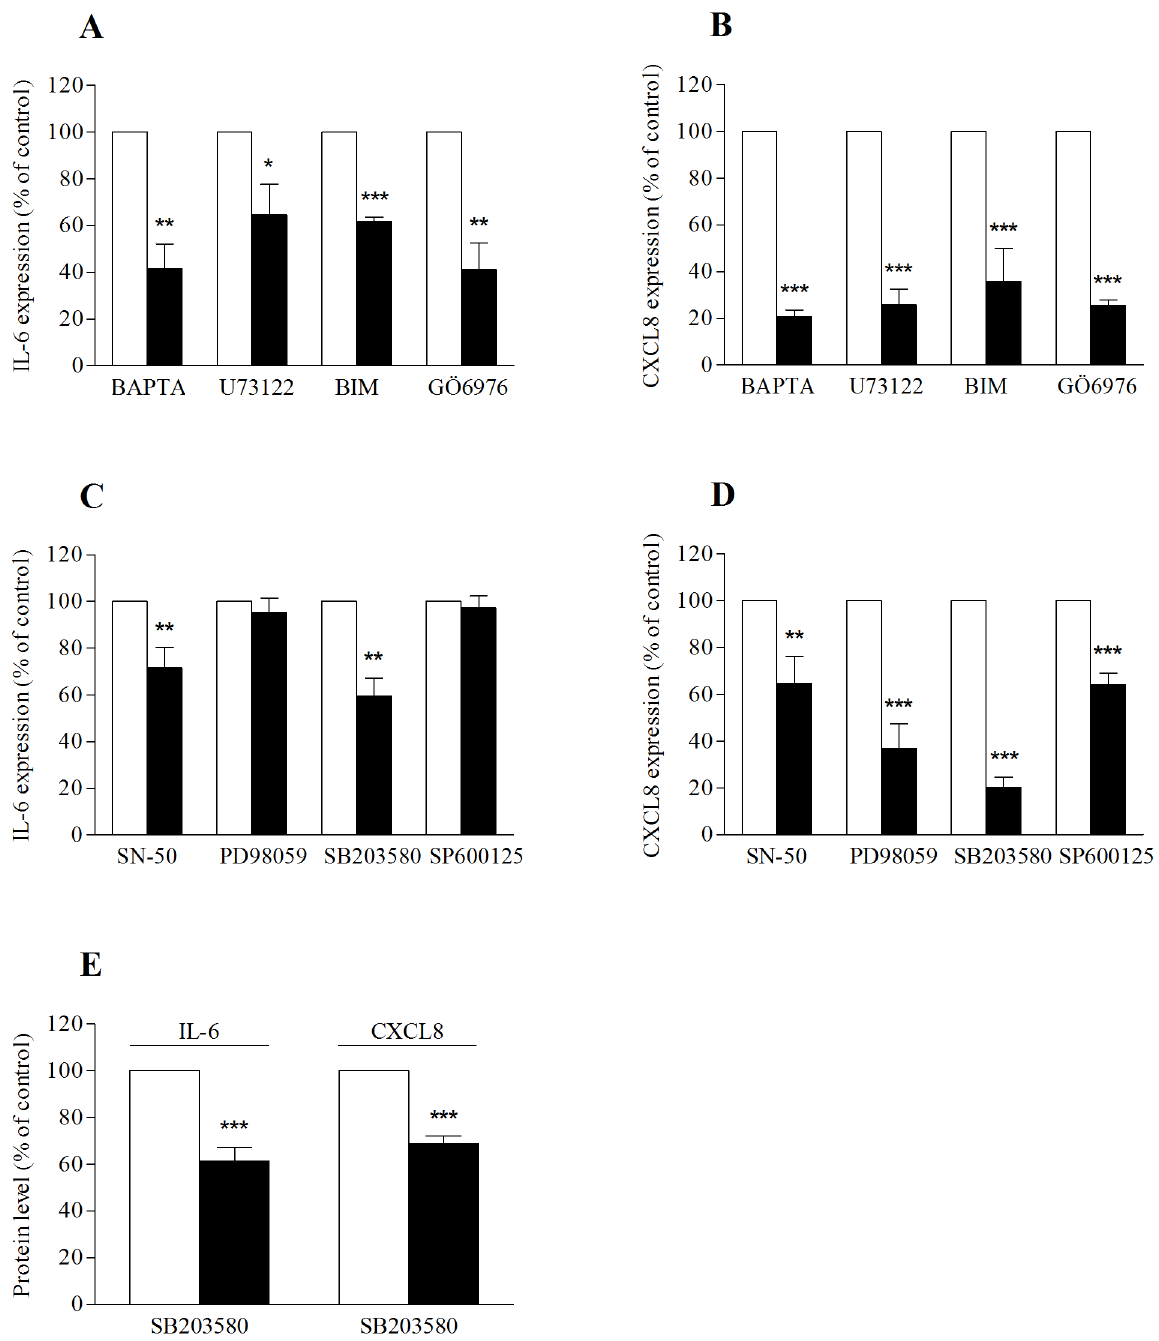
Fig 4. The cellular signaling mechanism by which inactivated-H5N1increasesmRNAfor IL-6 and CXCL8involves intracellular Ca 2+ , PLC, PKC, ERK1/2and p38 MAPK. 16HBE14o- cells were incubated with BAPTA-AM (50 μ M),U73122(10 μ M),BIM (1 μ M), Go¨6976(10 μ M) ( Aand B) , or with SN-50(10 μ M), PD98059 (50 μ M), SB203580(10 μ M)or SP600125(10 μ M) (C and D) , for 1 hr beforebeingexposedto inactivated-H5N1.Threehourslater, mRNA expressionof IL-6 (A and C) or that of CXCL8 (B and D) was analyzed.All data werenormalizedwith correspondingcontrolgroupstreated with inactivated-H5N1(openbars) and reportedas a percentage. (E) Cellsweretreated with SB203580(10 μ M)for 1 hr beforeincubationwith inactivated-H5N1(20 μ g/mlhemagglutinin). Thirty-six hours later, the cell-freeculturemediumwas harvestedand analyzedfor the presenceof IL-6 and CXCL8proteinsas describedin Fig 1.Data are presentedas a percentage of control(treated with inactivated-H5N1,openbar). Valuesare means μ SEM from at least 3 sets of experiments. * , ** and *** indicates p < 0.05, p < 0.01 and p < 0.001comparedwith control, respectively (unpairedStudent’s t -test).